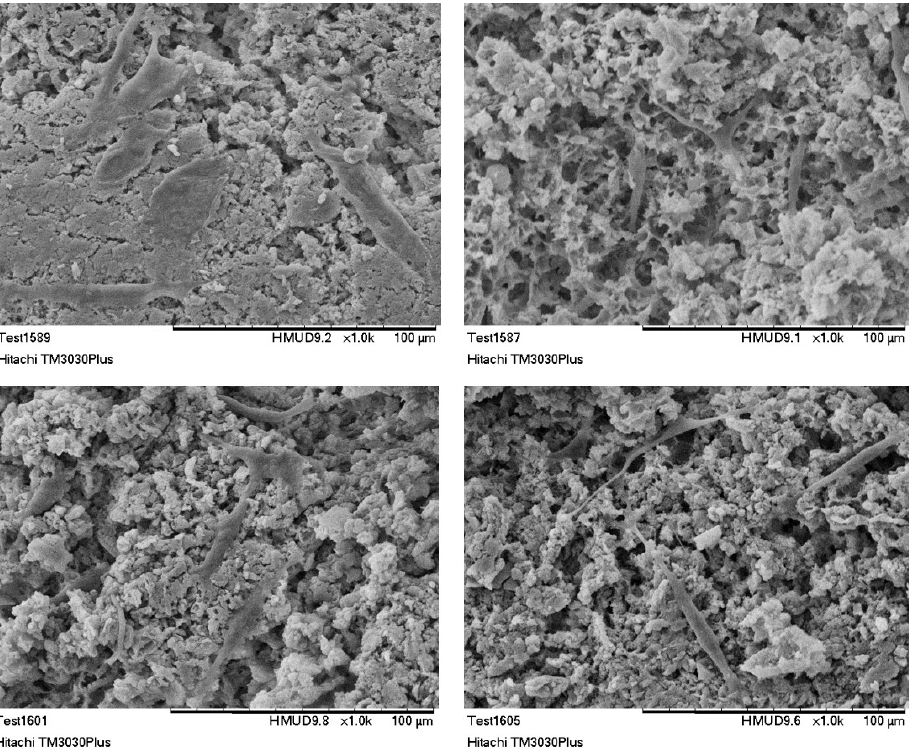
Figure 12. SEM images of MG63 cells cultured for 72 h on HAp-Col-Arg sca ff olds crosslinked with 0.01% riboflavin.